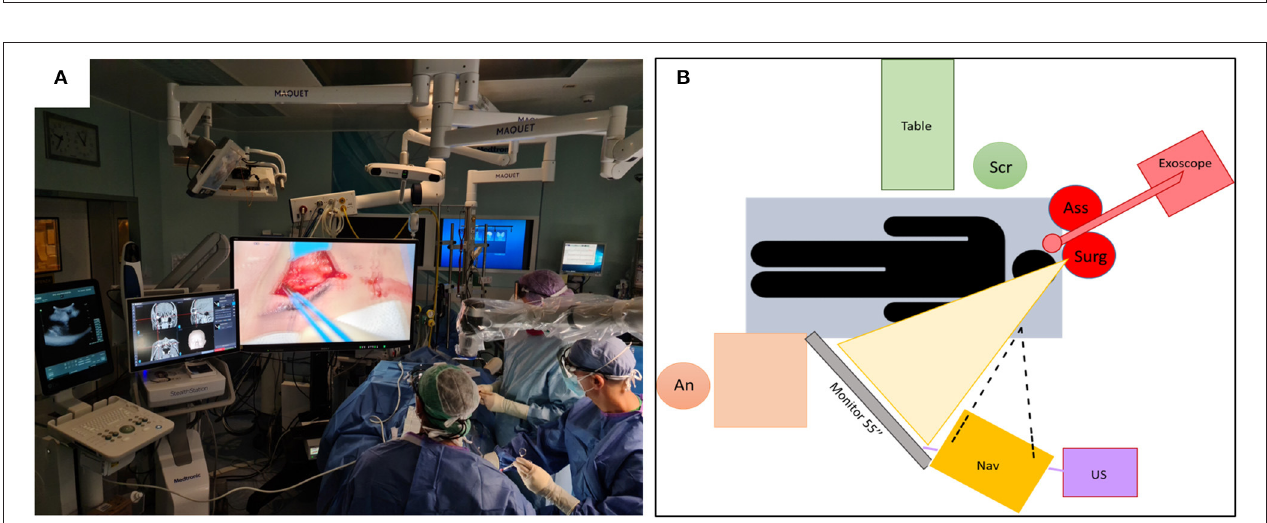
FIGURE 4 | Placement of the technologies in use (4K-3D camera, 55-inch monitor, navigator, and ultrasound) and staff within the OR during surgery for right transpalpebral approach (A) and scheme (B) . Note the comfortable position of the surgeon who can operate while looking at the monitor with the head in an upright